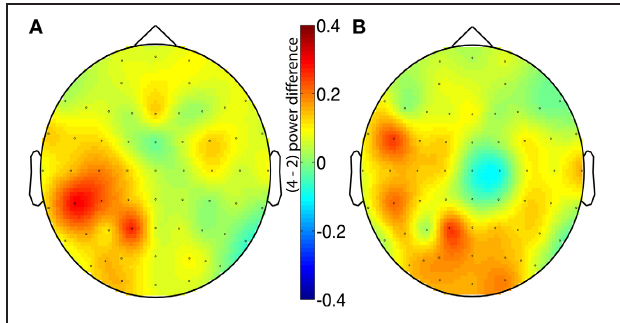
FIGURE 6 | No significant effect of memory load on alpha power during the period before probe appearance. Alpha-power difference between the 4 shapes and 2 shapes condition (4 shapes minus 2 shapes). (A) Average between − 800ms and − 500ms before probe onset. (B) Average between − 500ms and − 200ms before probe onset. No electrode showed a significant difference in power between conditions.